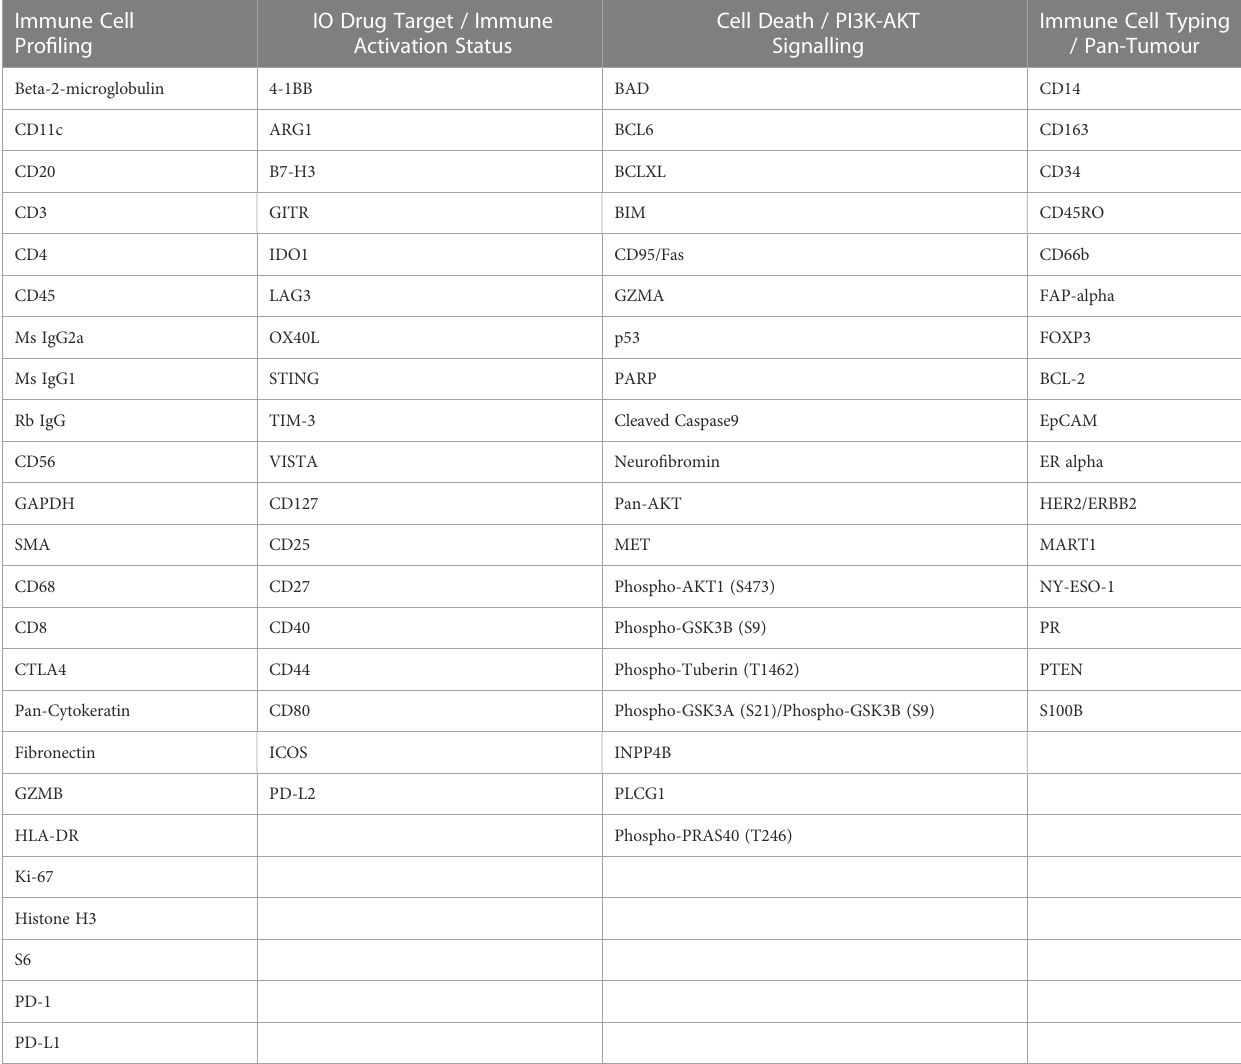
TABLE 2 Nanostring Technologies GeoMx DSP Immuno-oncology